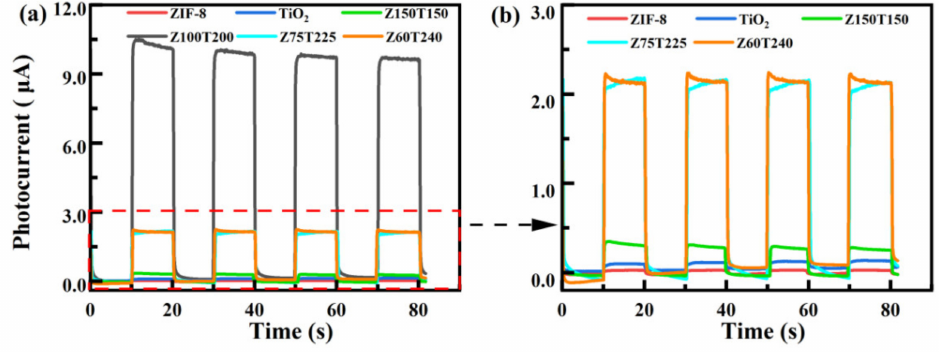
Figure 4. ( a ) Transient photo-current responses of ZIF-8, TiO 2 , and ZIF-8@TiO 2 (Z x T y ); ( b ) Partial enlarged drawing of ( a